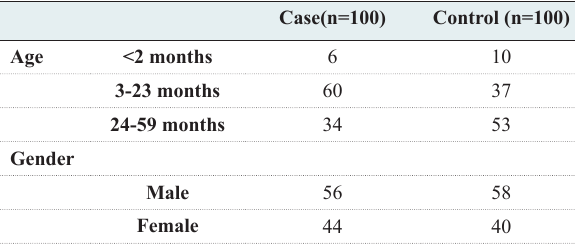
Table 1: Demographic variables for age and gender